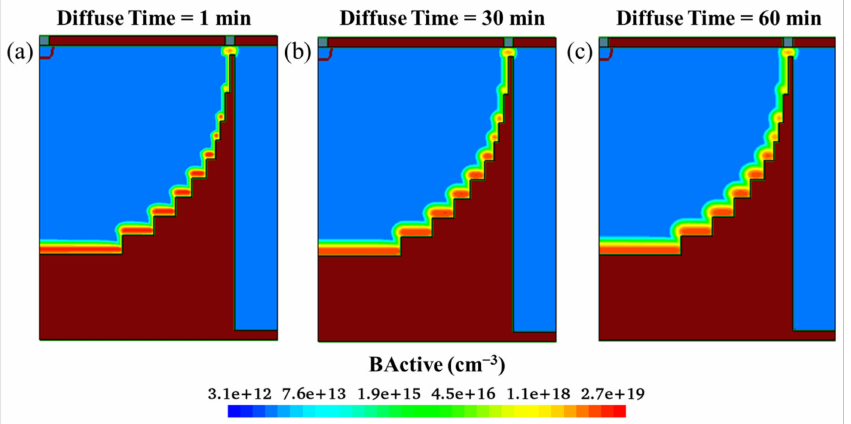
Figure 14. Doping profiles after annealing with different diffuse times ( a ) 1 min; ( b ) 30 min; ( c ) 60 min.